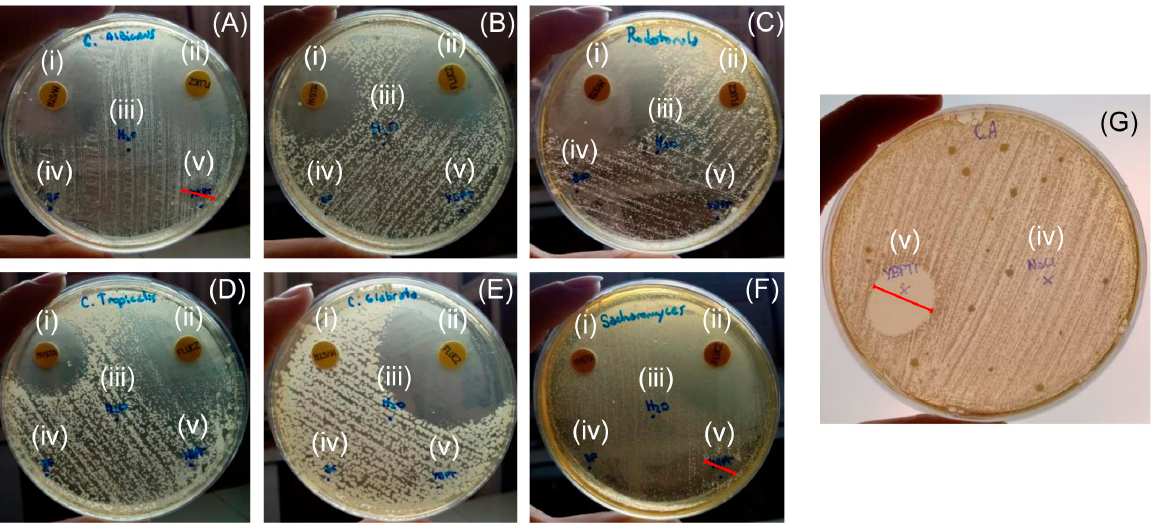
Figure 3. Growth inhibition of fungal strains by YBPTI. The growth inhibition of seven fungal strains was evaluated by agar diffusion: ( A ) C. albicans , ( B ) C. krusei , ( C ) Rodothorula , ( D ) C. tropicalis , ( E ) C. glabrata , ( F ) S. cerevisiae . In ( A – F ) 5 µ g of YBPTI were tested. In ( G ), C. albicans was assayed with 66 µ g YBPTI. The treatments are: (i) Nystatin, (ii) Fluconazole, (iii) distilled water, (iv) 100 mM phosphate buffer pH 7.4, (v) YBPTI.